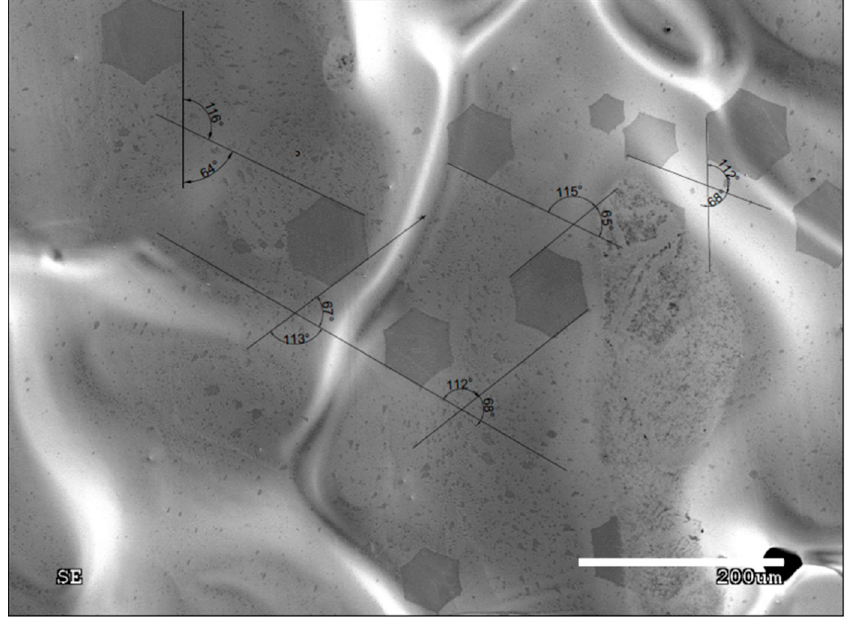
Figure 4. SEM image of the misorientation angles between the individual graphene domains.